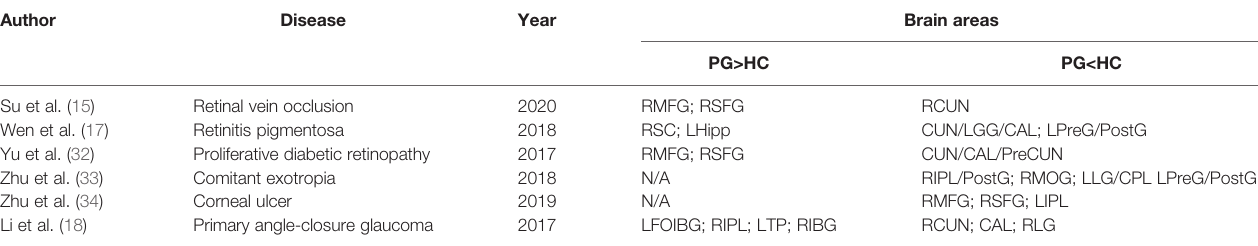
TABLE 6 | FC technique used in ophthalmological diseases.